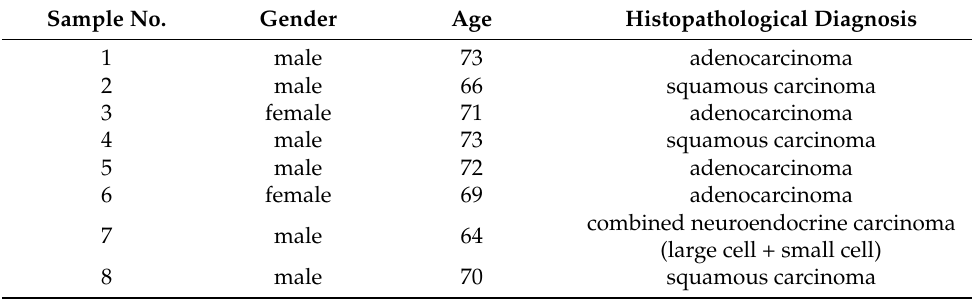
Table 2. Basic specifications of tumor biopsies donated by NSCLC patients. Sample